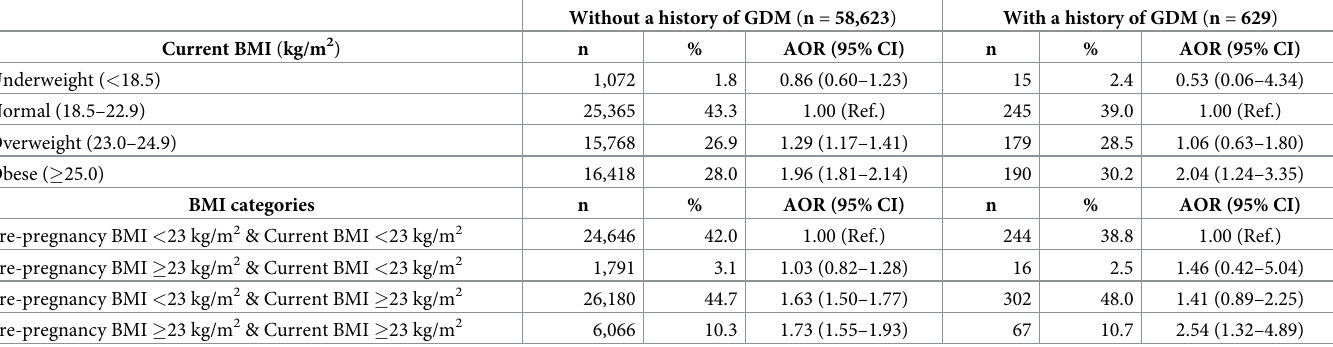
Table 5. Association between current BMI and type 2 diabetes according to the status of GDM history in the Health Examinee Study (HEXA) 2004–2013. Without a history of GDM ( n = 58,623 ) With a history of GDM ( n = 629